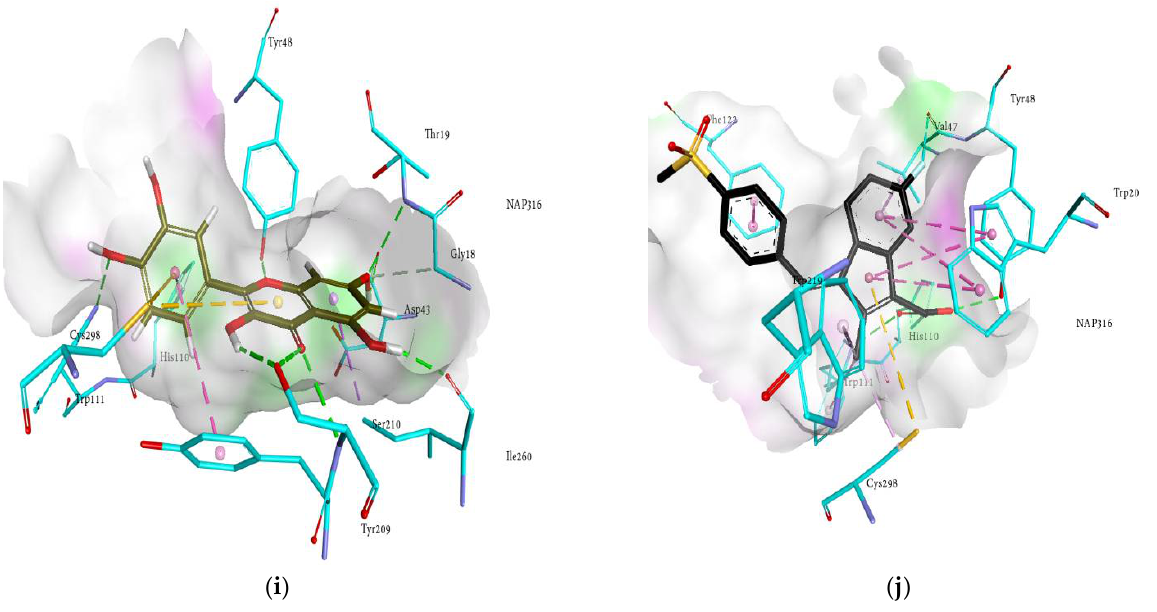
Figure 4. Molecular docking models for RLAR inhibition by ginsenosides and diagrams of ligand 3D interactions and the major binding sites of the eight ginsenosides in the RLAR active site; protopanaxadiol ( a ), (20 S ) ginsenoside Rg3 ( b ), (20 R ) ginsenoside Rg3 ( c ), ginsenoside Rh2 ( d ), protopanaxatriol ( e ), ginsenoside Rf ( f ), (20 S ) ginsenoside Rg2 ( g ), ginsenoside Rh1 ( h ), quercetin ( i ), and sulindac ( j ). The interactions are shown by green (conventional hydrogen bonding), yellow (π- sulfur interactions), tea pink (π-π T-shaped and π-π stacked interactions), cyan (fluorine) and yellow (π-sulfur).